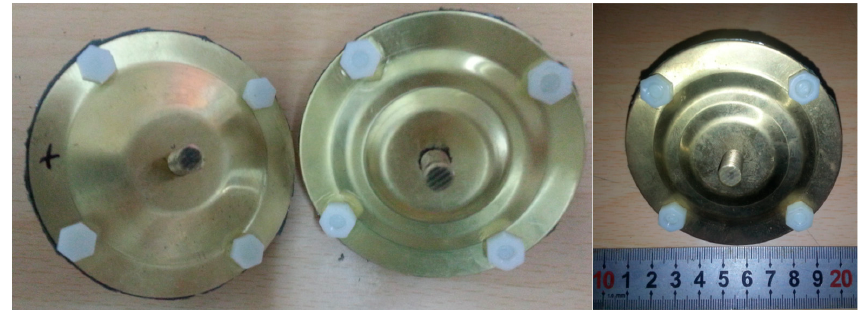
Figure 10. Two constructed transducers.